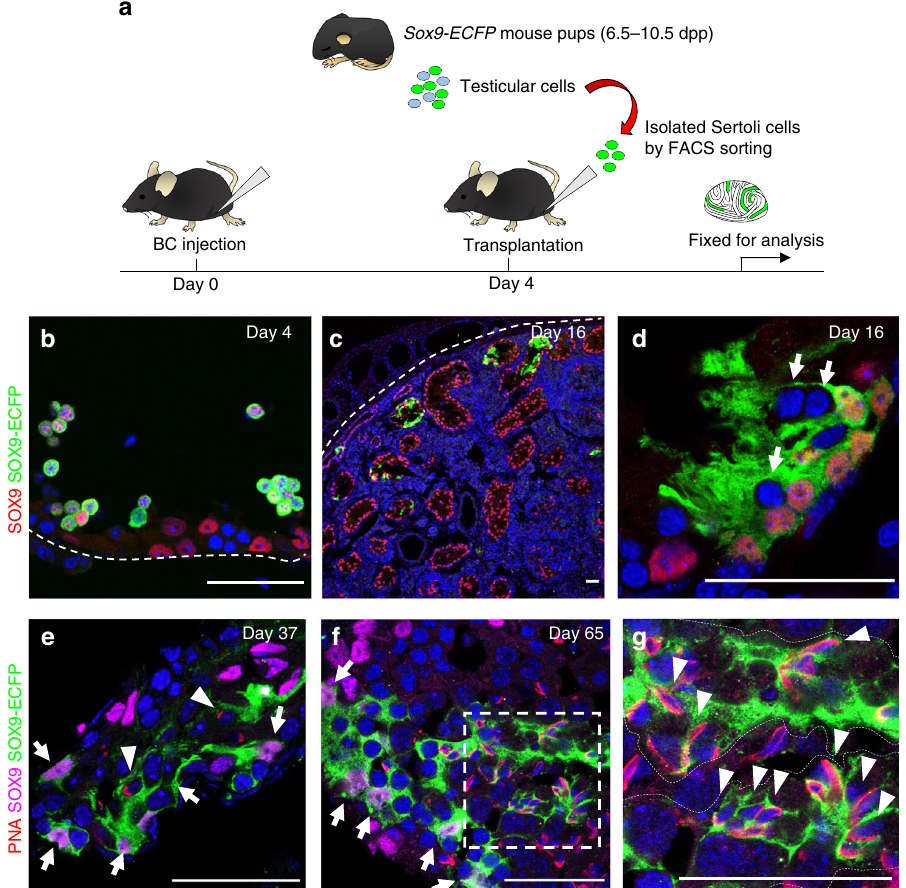
Fig. 3 Transplantation of Sertoli cells reconstituted the germ cell niche and rescued spermatogenesis. a FACS-isolated Sertoli cells from 6.5 – 10.5 dpp pups were transplanted into adult testis 4 days after BC treatment. b On the day of transplantation (day 4), donor cells were detected in the lumen of seminiferous cords. Donor Sertoli cells were SOX9-ECFP (green, cytoplasmic stain), and also labeled with an antibody against native SOX9 (red, nuclear stain). Some host Sertoli cells remained, also labeled with native SOX9 (red), but not ECFP (green). c , d Twelve days after transplantation, donor Sertoli cells (SOX9-ECFP positive, green) isolated from 10.5 dpp pups colonized in some host seminiferous tubules and contacted host germ cells (arrows, cytoplasm surrounding round blue nucleus is not green). e – g Recipient testis stained with SOX9-ECFP (green), antibodies against SOX9 (magenta), the acrosomal marker PNA (red), and Hoechst (blue) are shown. Donor Sertoli cell contribution was observed in two in four biologically independent testis examined over two independent experiments. Arrows point to donor Sertoli cells with green cytoplasm. e Recipient testis 33 days after transplantation of Sertoli cells from 6.5 dpp Sox9-ECFP pups, showing that primitive spermatids (arrowhead), are present surrounded by donor Sertoli cells (green, arrow). f On day 65, donor Sertoli cells from 7.5 dpp Sox9-ECFP pups (green, arrows) supported spermatogenesis from host spermatogonia. Area within broken lines is enlarged in g , where elongated spermatids with a PNA-positive acrosomal cap were present (arrowheads) surrounded by donor Sertoli cell cytoplasm (green, within dotted lines). Scale bar: 50 µ